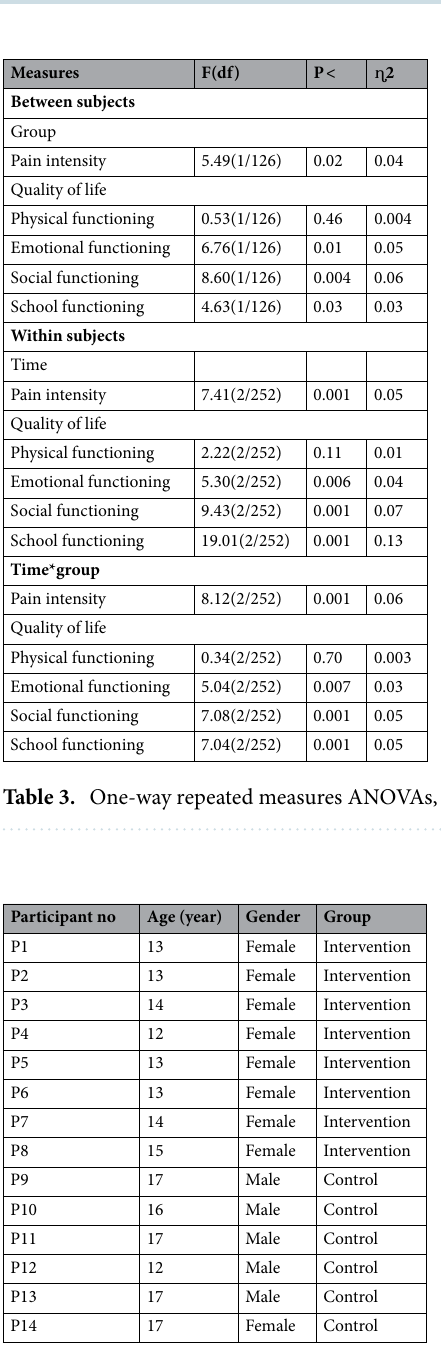
Table 4. The demographic details of the participants in the qualitative